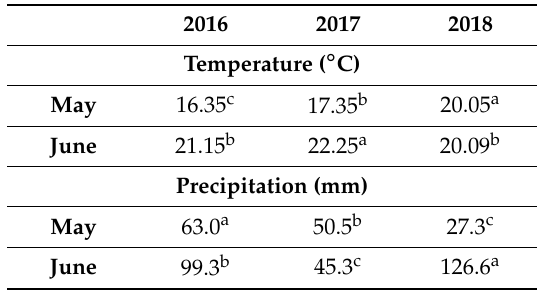
Table 2. Statistical analysis of the temperature and precipitation in May and June for each